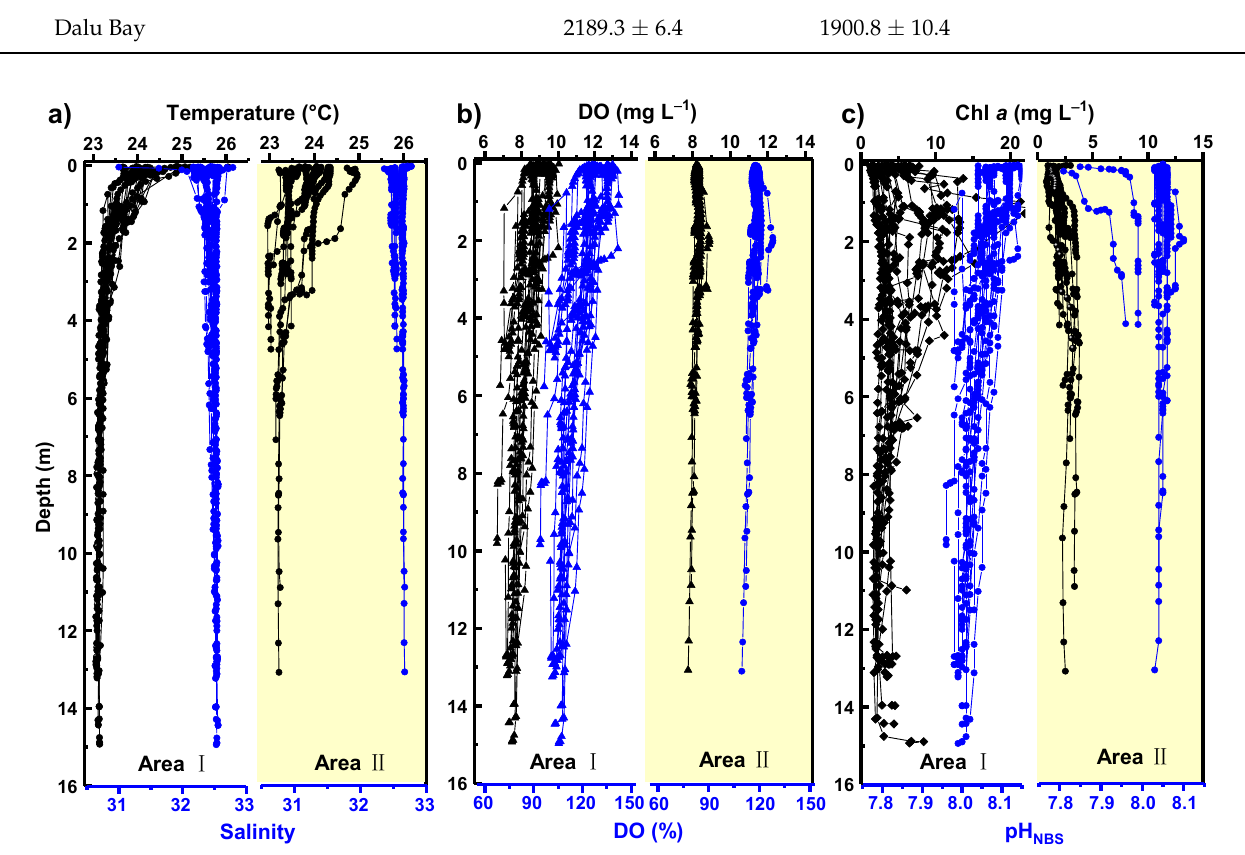
Figure A1. Distribution characteristics of temperature and salinity ( a ), DO ( b ), Chl a and pH NBS ( c ) in Yangmeikeng Sea Area (Area I) and Dalu Bay (Area Ⅱ ).